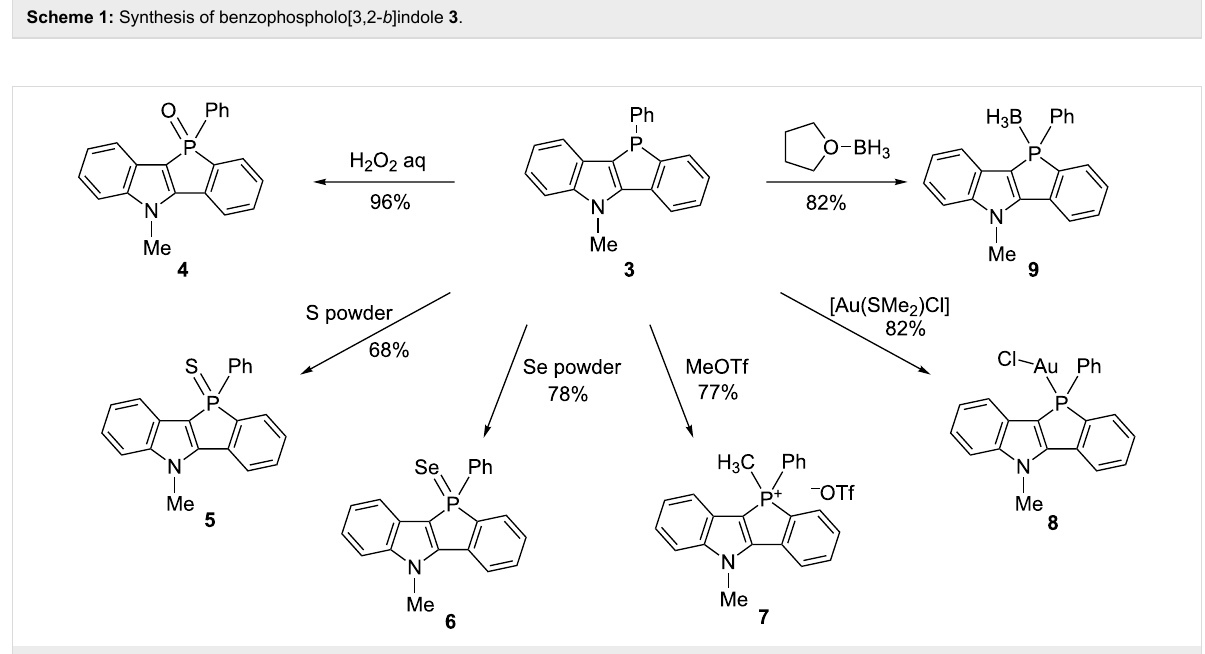
Scheme 2: Chemical modifications of the phosphorus atom of 3 .